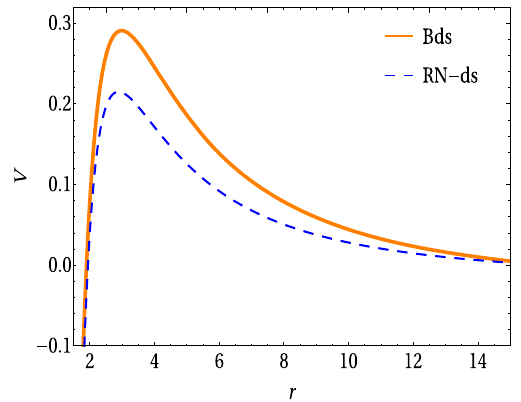
Fig. 1 Effective potential V for BdS and RN-dS black holes for q = 0 . 40, (cid:12) = 2 and (cid:2) = 0 .